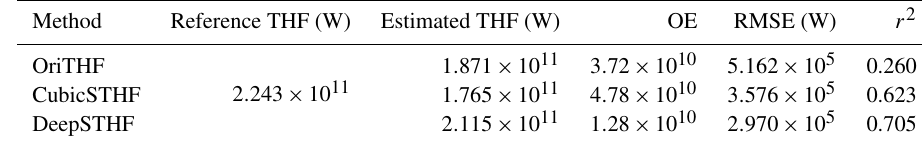
Table 2. Accuracies of the estimated turbulent heat flux (THF) estimated by different methods.